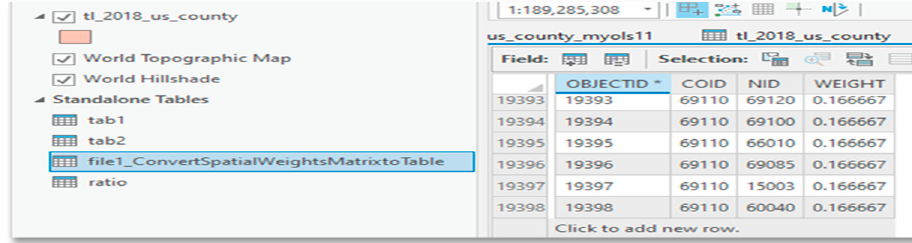
Figure 7. Model result parameter table example.